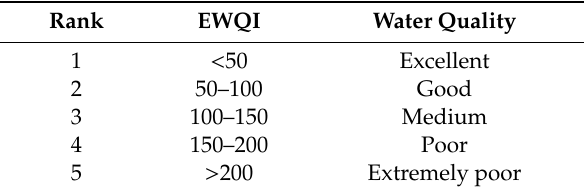
Table 1. Classification criteria of water quality based on the EWQI. Rank EWQI Water